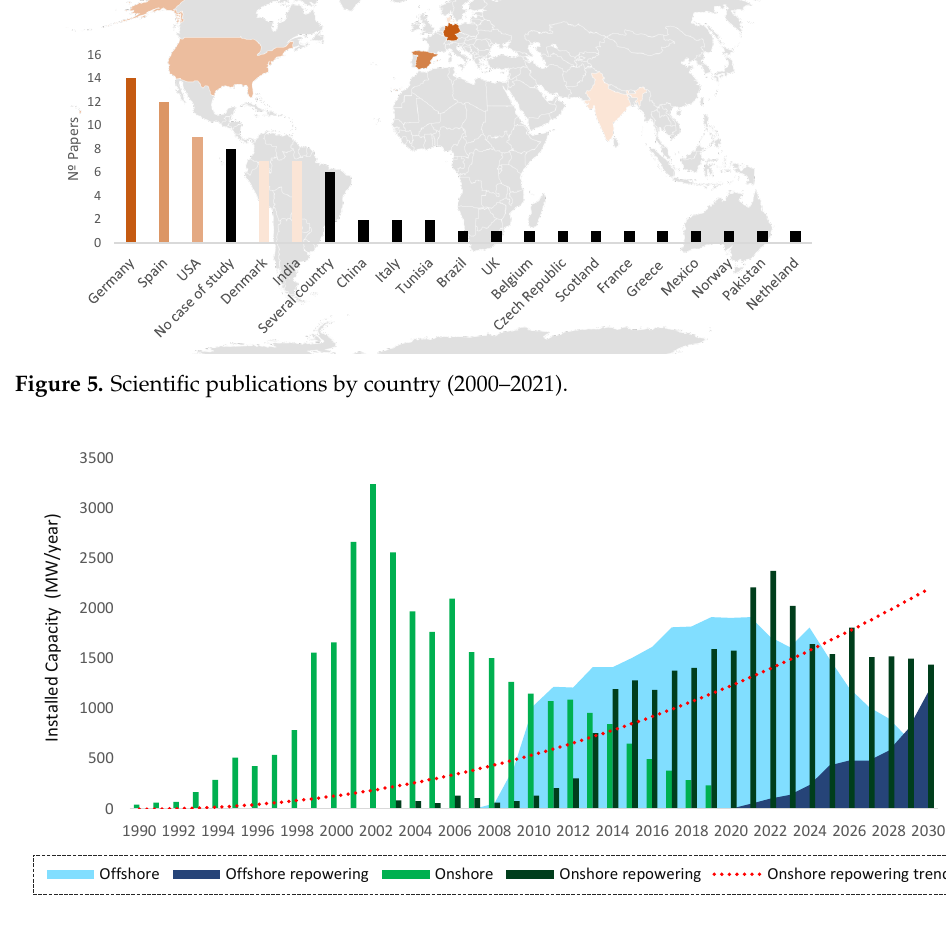
Figure 6. Annual installed capacity versus repowering market. Germany (source: own